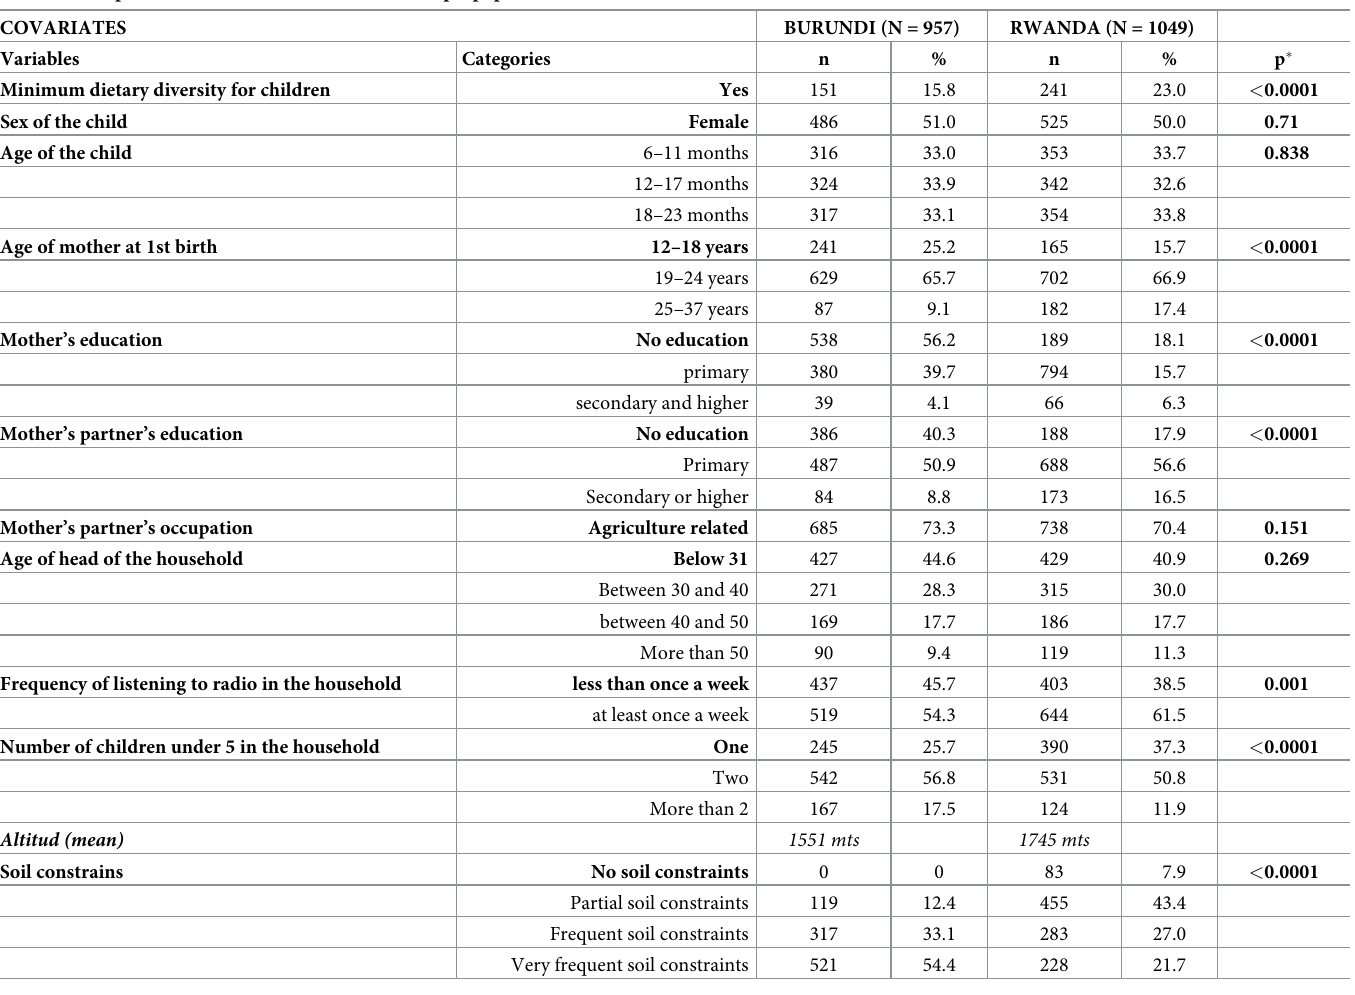
Table 1. Comparison of Burundi’s and Rwanda’s sample populations. DHS